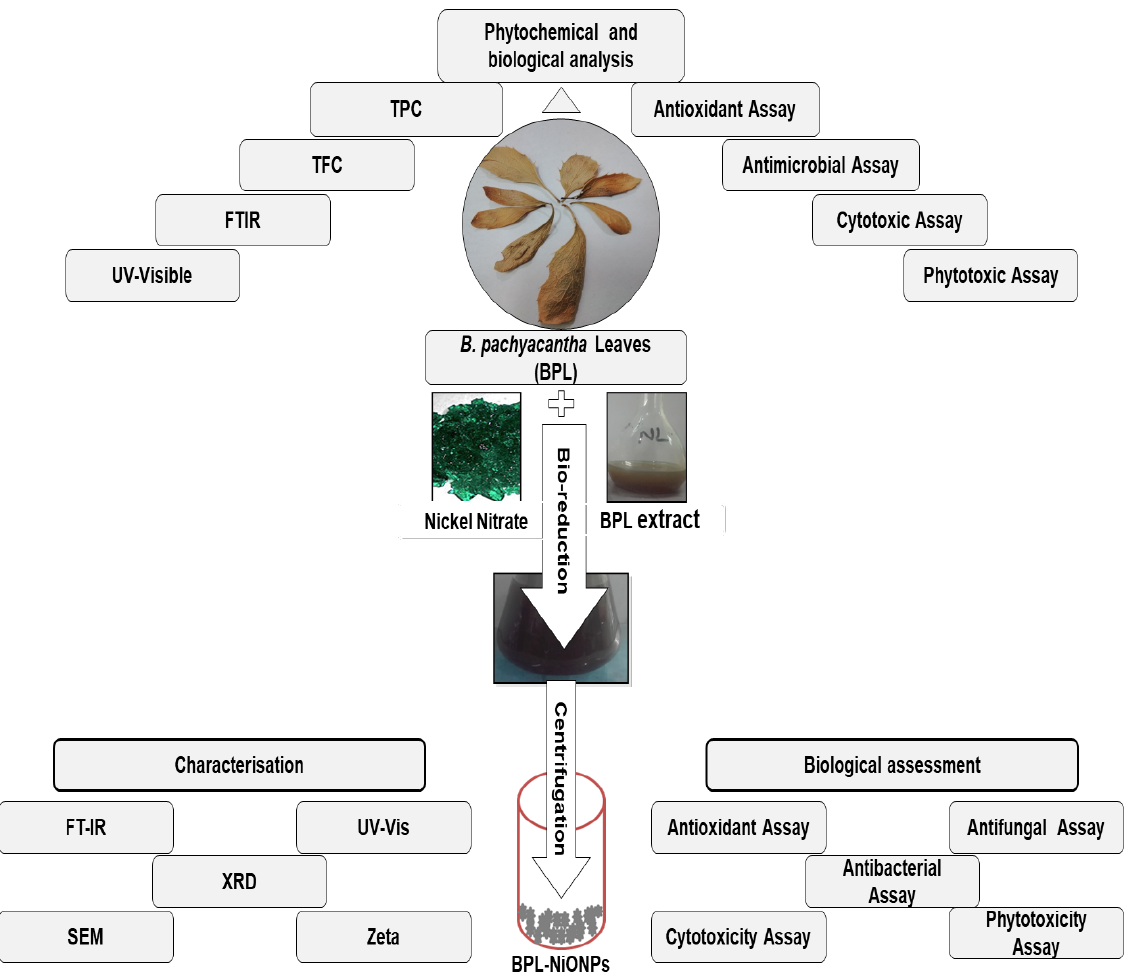
Figure 10. Layout of green synthesized BPL extract and BPL-NiONPs, characterizations and multiple biological applications.